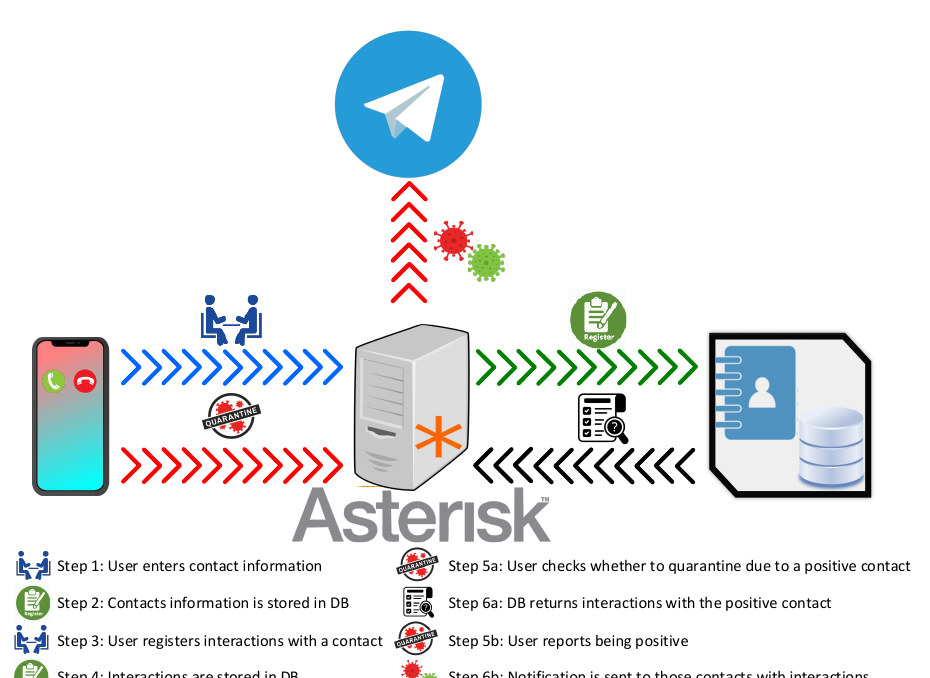
Figure 6. Architecture of the project to develop a COVID-19